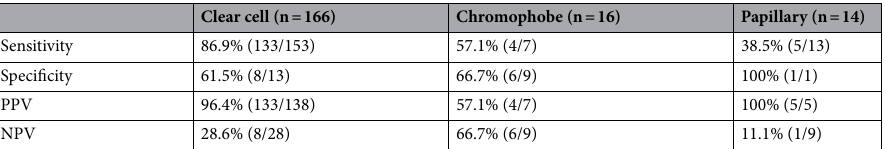
Table 3. Detection of peritumoral pseudocapsule in each pathological subtype on contrast enhanced CT. PPV positive predictive value, NPV negative predictive